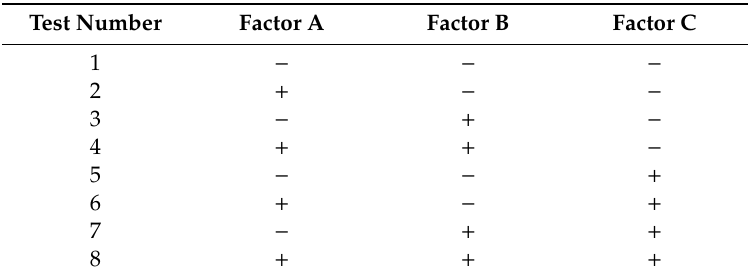
Table 2. Setting of input factors according to the full factorial